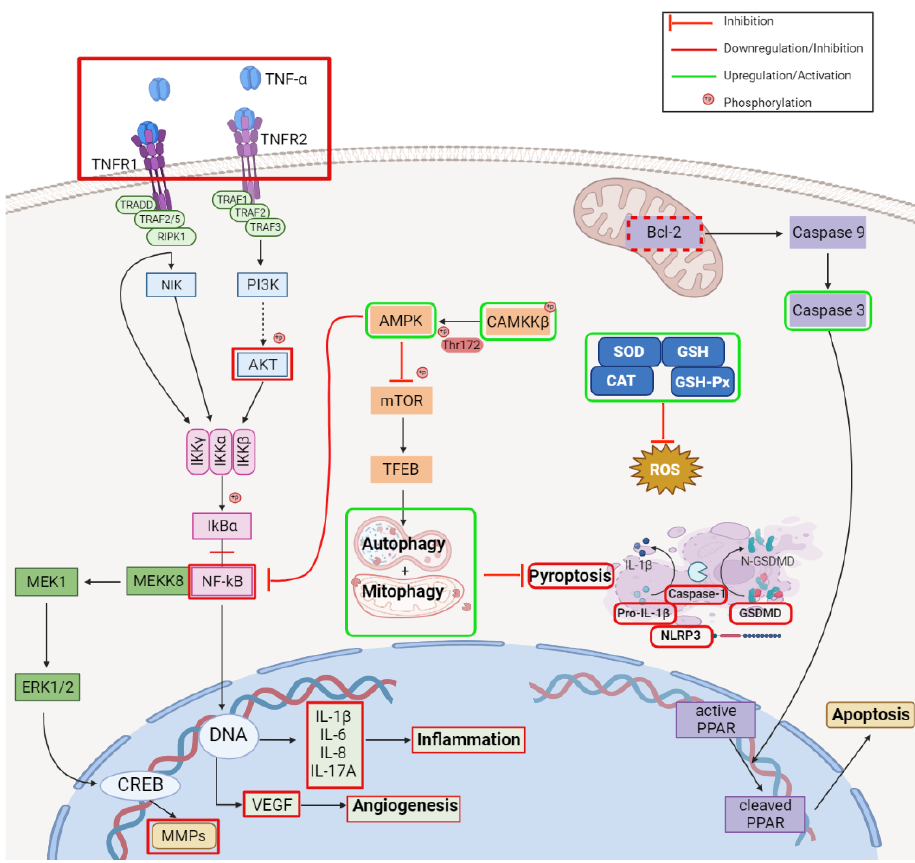
Figure 5 . Schematic representation of the reported anti-inflammatory mechanisms of betulinic acid; key signaling pathways targeted. Created with BioRender.com (accessed on 23 June 2022).